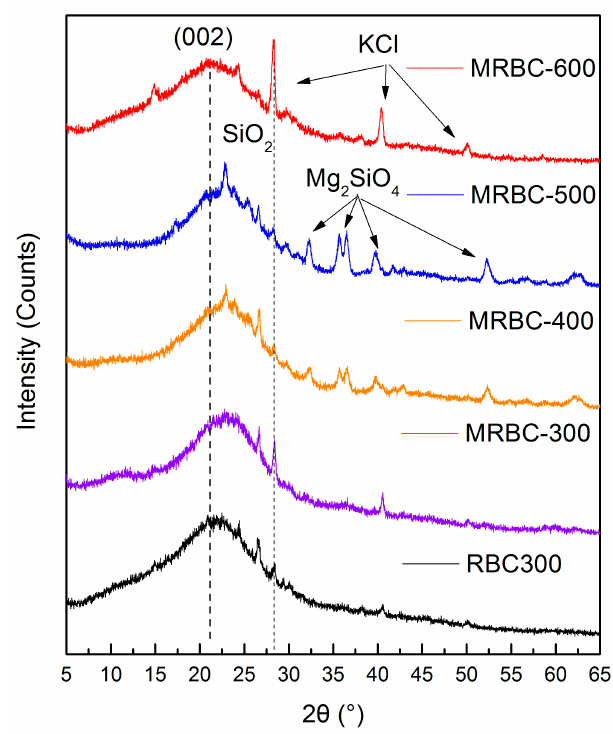
Figure 5. XRD patterns of RBC300 and MRBCs.